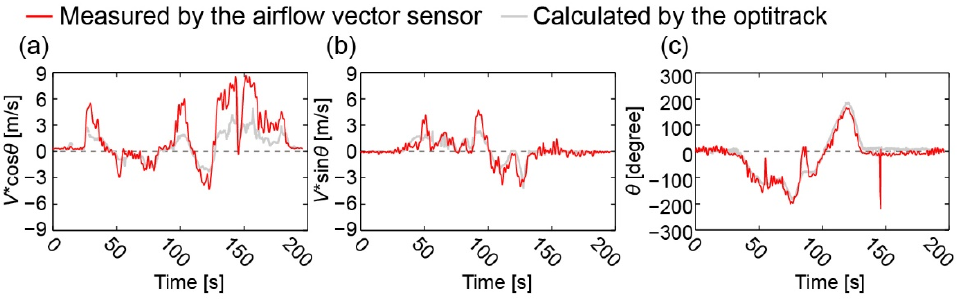
Figure 12. Measured ( a ) V · cos θ , ( b ) V · sin θ , and ( c ) θ during the drone